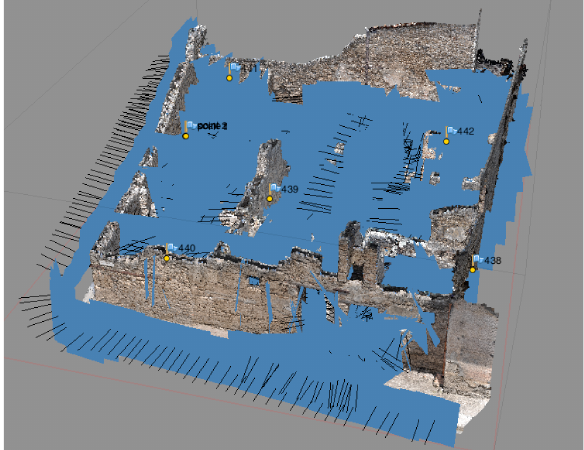
Figure 4. Terrestrial photogrammetry - location and direction of photos for 3D